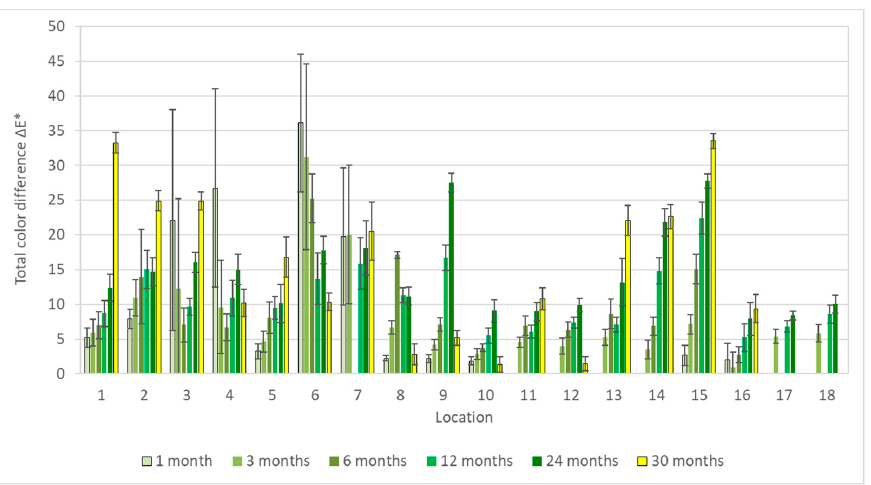
Figure 3. Comparison of the appearance of silver coupons stored in an open area of a library ( left ), in a wooden cabinet ( middle ), and in a church ( right ).